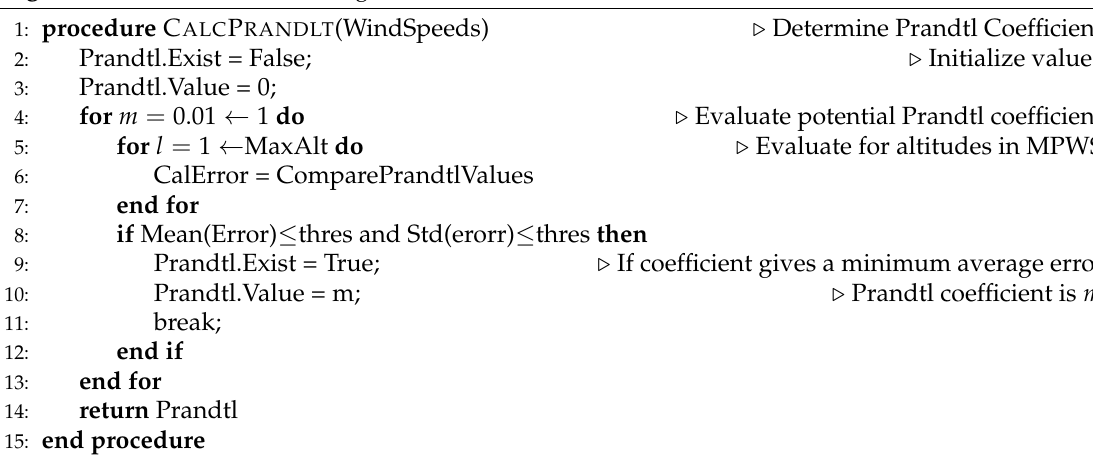
Algorithm 4 Wind Prediction Algorithm.